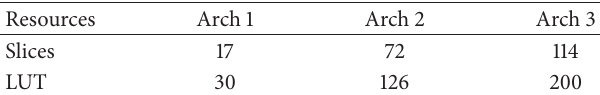
Table 8: Resource utilization of different multiplier implementa- tion.